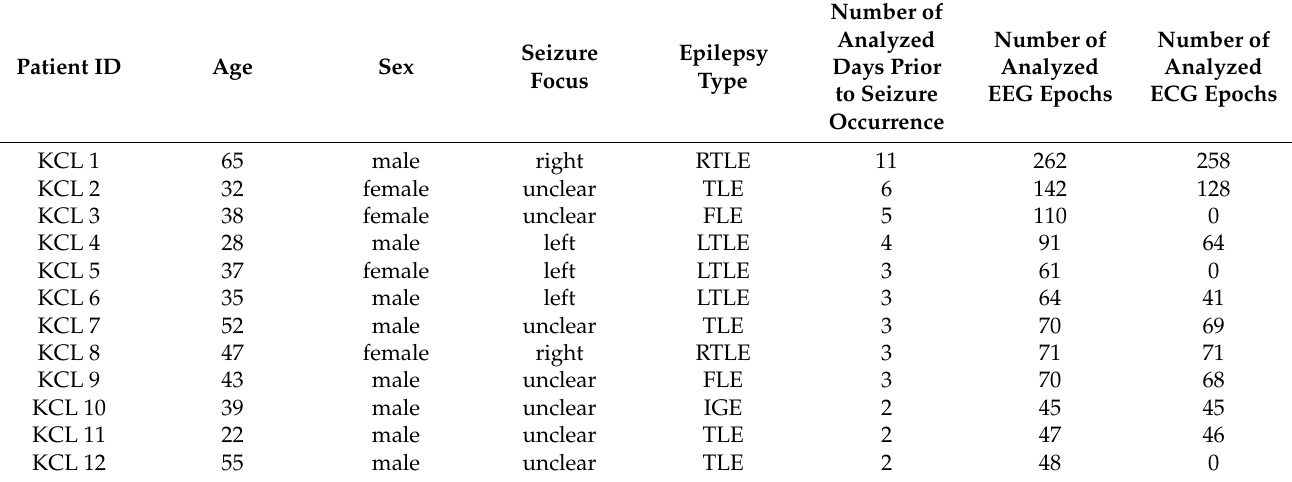
Table 1. Demographic information of the study